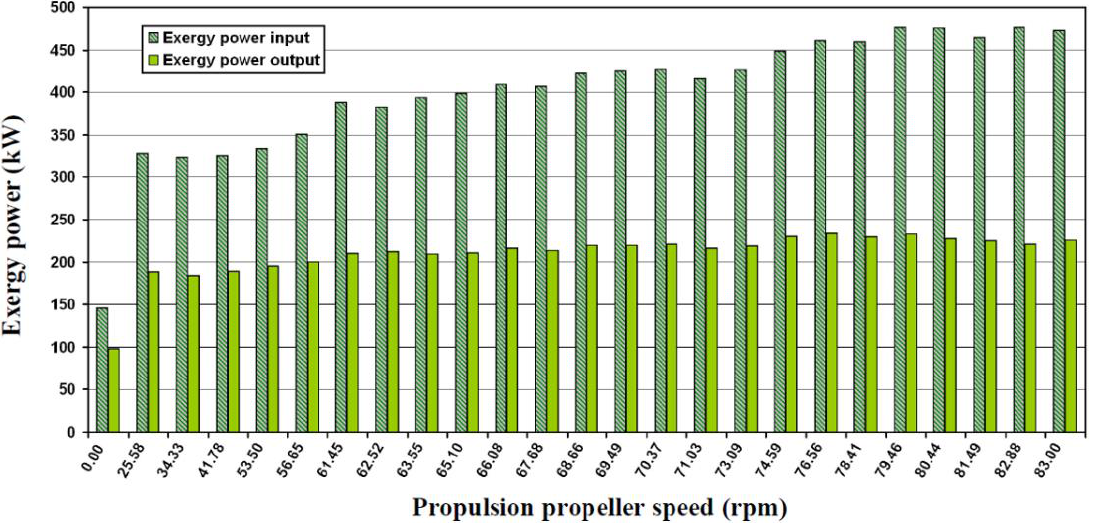
Figure 6. Steam air heater exergy power input and output for various loads.